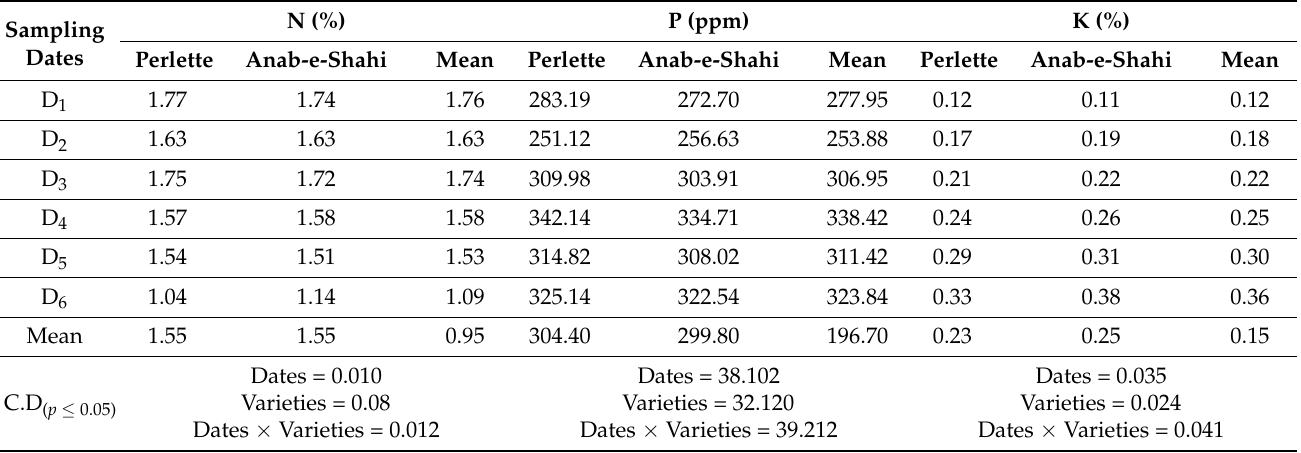
Figure 1. Change of Nitrogen (N%) concentration during the development of berries in grapes, cv. Perlette and Anab-e-Shahi. Table 1. Periodical variation of primary nutrients in developing berries of grapes during the grow- ing